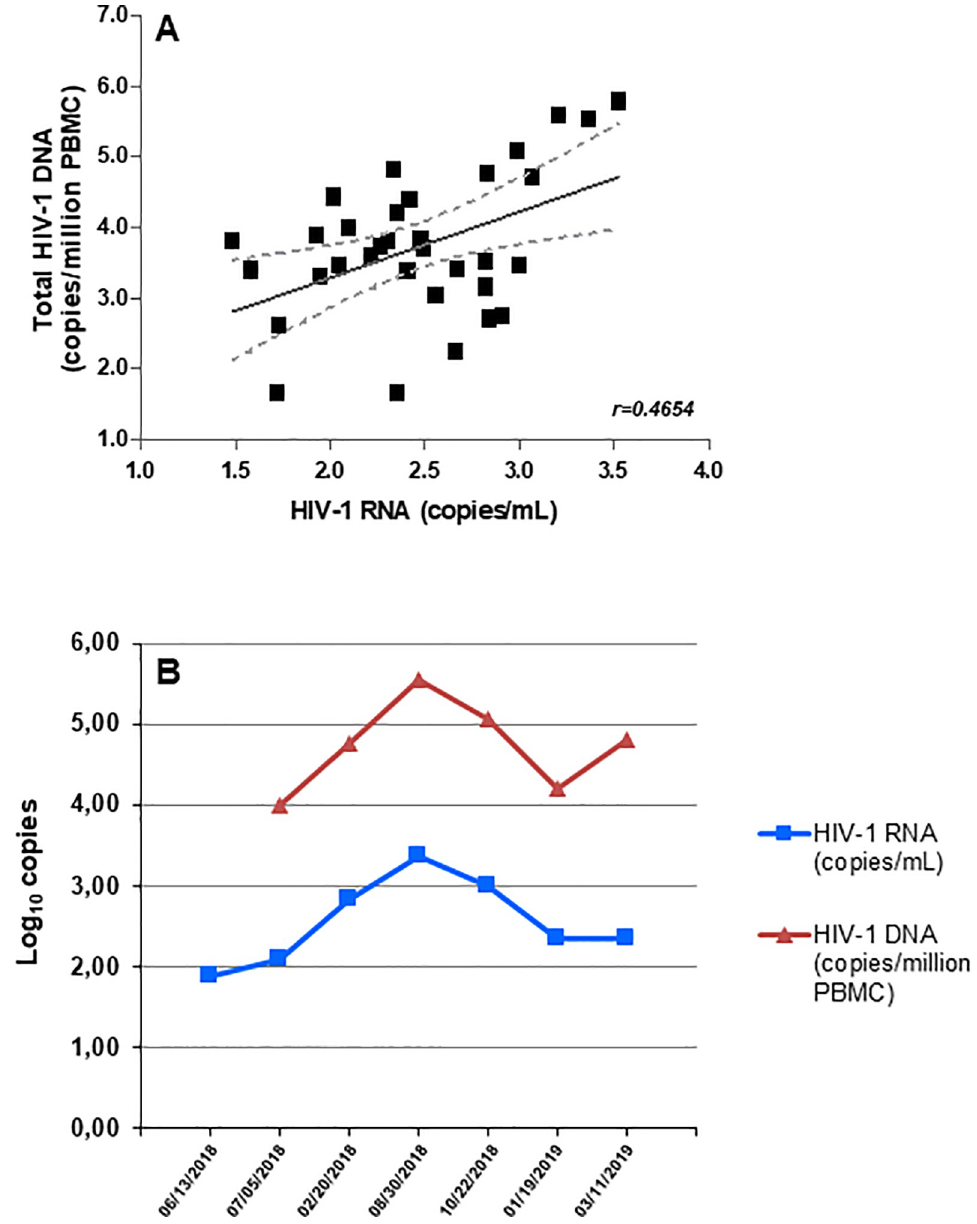
Fig 2. Correlation between LTR -detected HIV-1 RNA and PBMC-associated total HIV-1 DNA levels. (A) Correlation between VL levels detected by LTR region and total HIV-1 DNA content measured in PBMC in 33 samples ( p = 0.0063; 95% confidence interval of the regression, shown with dashed lines). (B) Kinetics of plasma HIV-1 RNA (blue square symbols) and PBMC-associated total HIV-1 DNA (red triangle symbols) in one representative patient, showing viremia repeatedly detected with LTR